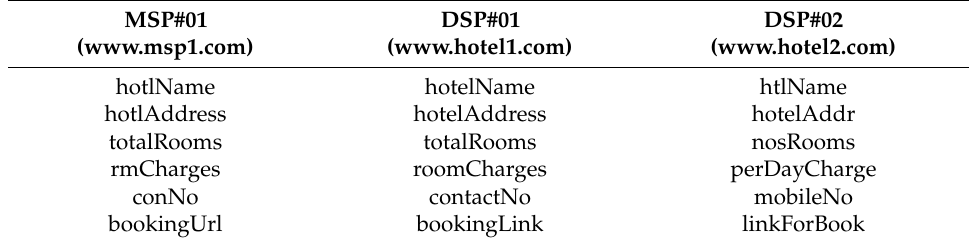
Table 9. End to End SDXMapping between MSP#01 and (DSP#01 and